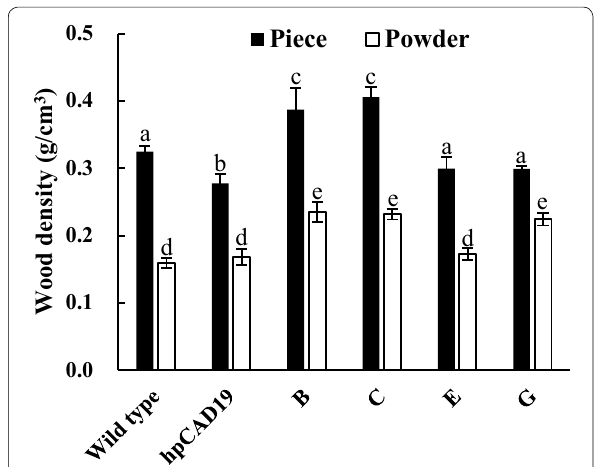
Fig. 5 Densities of dried wood pieces and of cell wall residues (powders) prepared from the stem of each line. Three biological replicates were used in the analysis. Different letters indicate statistically significant differences between the various lines at P < 0.01 determined by one-way ANOVA followed by Tukey multiple comparison tests. Error bars indicate the standard